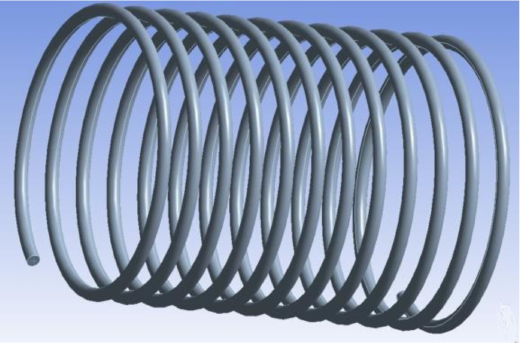
Figure 4. Coil of direct-flow steam boiler